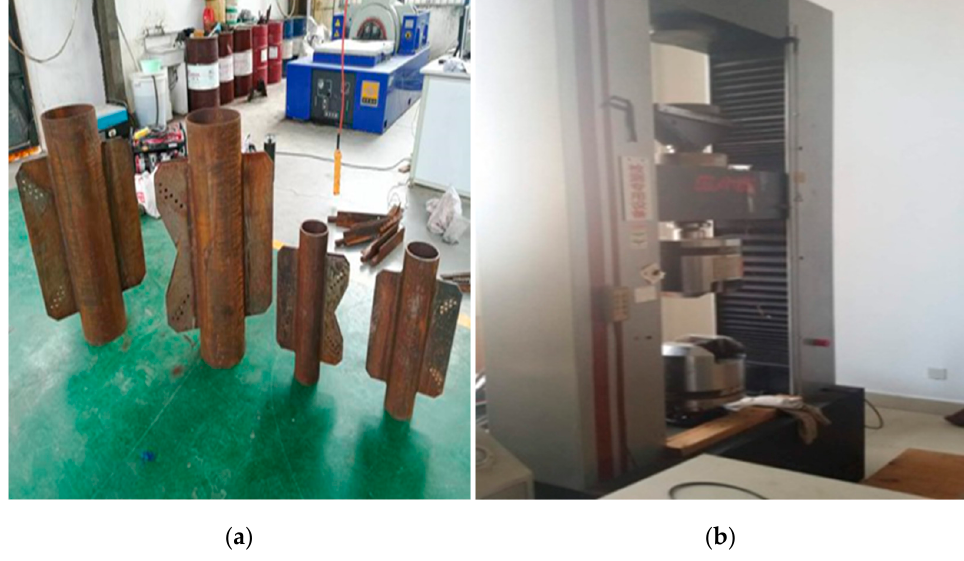
Figure 10. ( a ) Physical drawing of specimen; ( b ) electro-hydraulic servo universal testing machine.